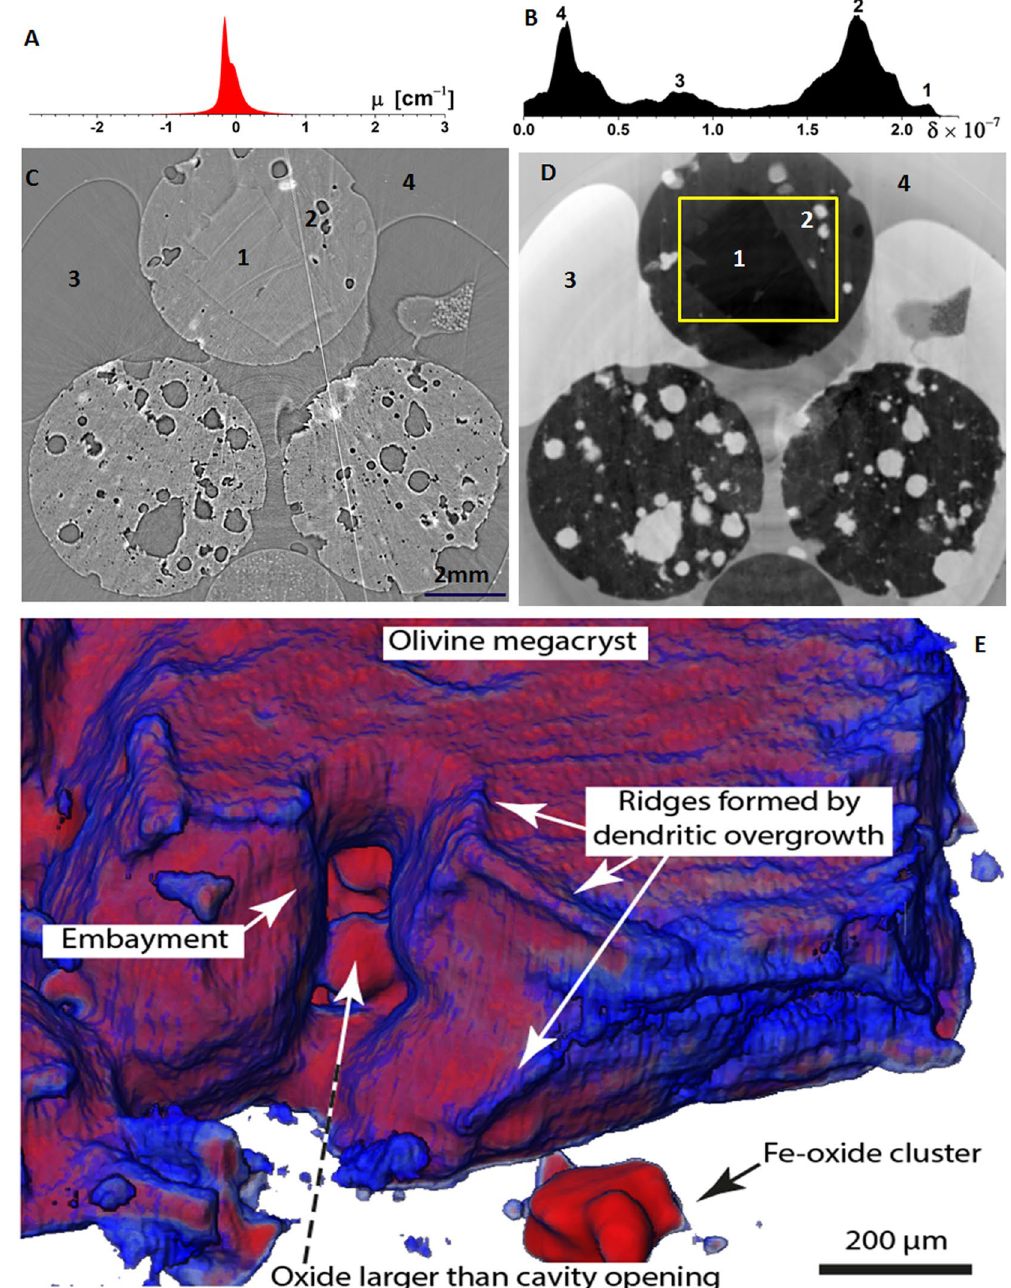
Figure 5. Reconstructed axial slices of picrite rock cores using transmission data ( C ) and phase data ( D) . ( A , B ) are histograms of all the pixels in ( C , D ). (1) The olivine crystal, (2) glassy groundmass, (3) paraffin wax and (4) the air can be clearly identified in the phase signal data. ( E ) Volume rendering of phase contrast image focusing upon the edge of the large olivine crystal (box in D ). Numerous textural features are made visible and allow 3D petrologic interpretation, such as the timing of crystal contact and growth